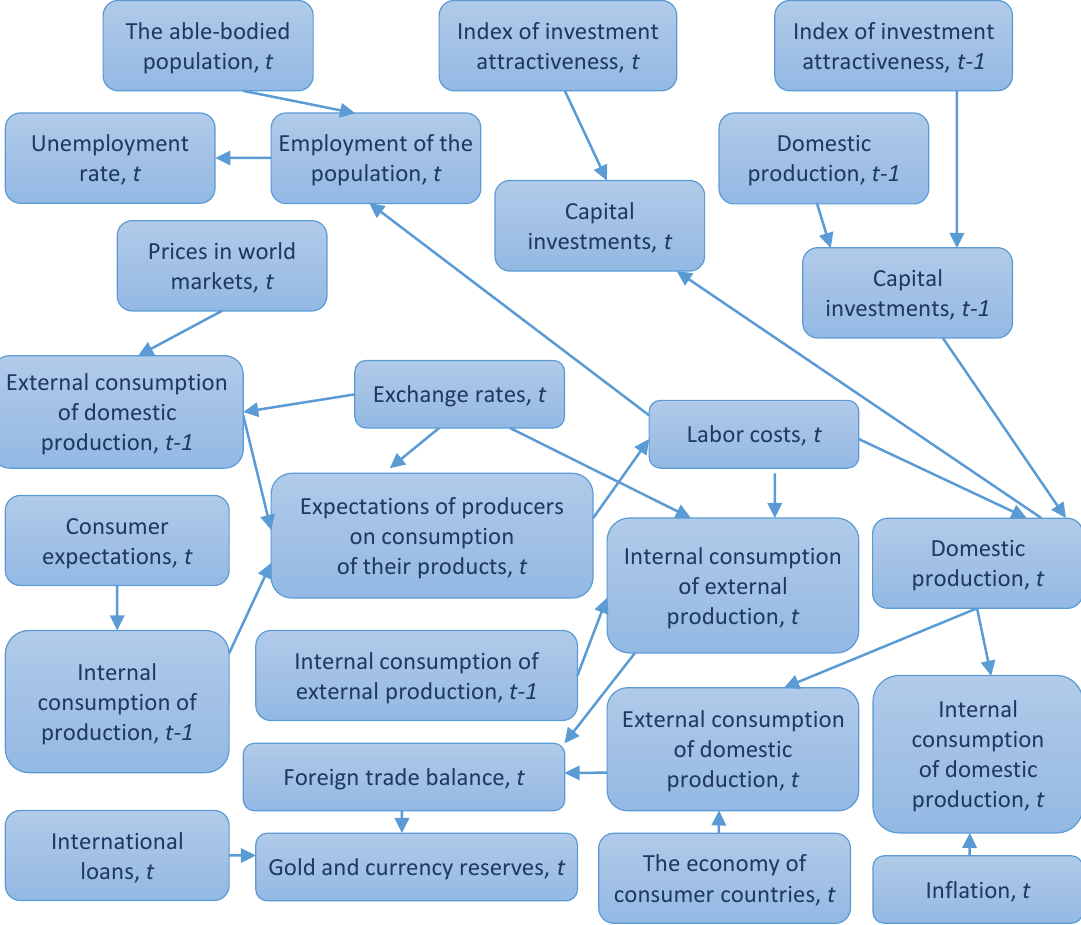
Figure 2. Scheme of the main interrelations between the indicators of the model of diversification of foreign economic interactions